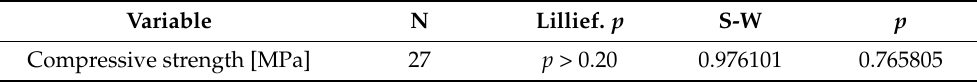
Table 8. The results of the Lilliefors test and the Shapiro–Wilk test. Variable N Lillief. p S-W